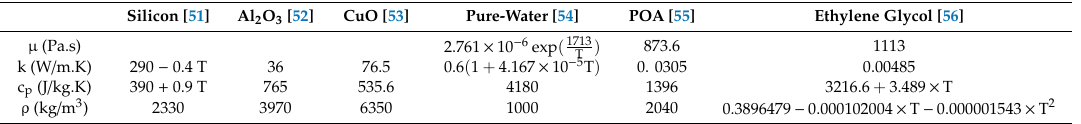
Table 2. Thermo-physical properties of pure water, POA, ethylene glycol, silicon, Al 2 O 3 and CuO. Silicon [51] Al 2 O 3 [52] CuO [53] Pure-Water [54] POA[55] Ethylene Glycol [56] µ (Pa.s) 2.761 × 10 − 6 exp ( 1713 ) 873.6 1113 T k (W / m.K) 290 − 0.4 T 36 76.5 0.6 ( 1 + 4.167 × 10 − 5 T ) 0. 0305 0.00485 c p (J / kg.K) 390 + 0.9 T 765 535.6 4180 1396 3216.6 + 3.489 × T ρ (kg / m 3 ) 2330